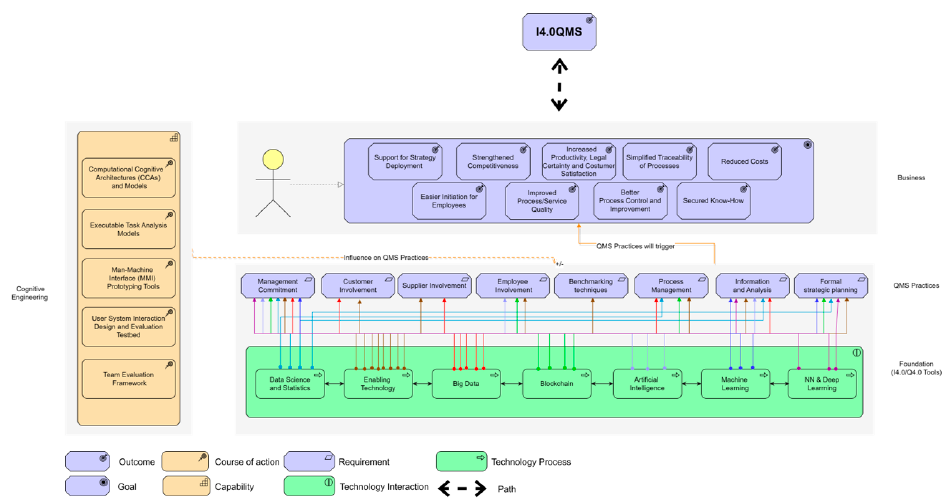
Figure 4. Conceptual Framework to aim in the application of a QMS